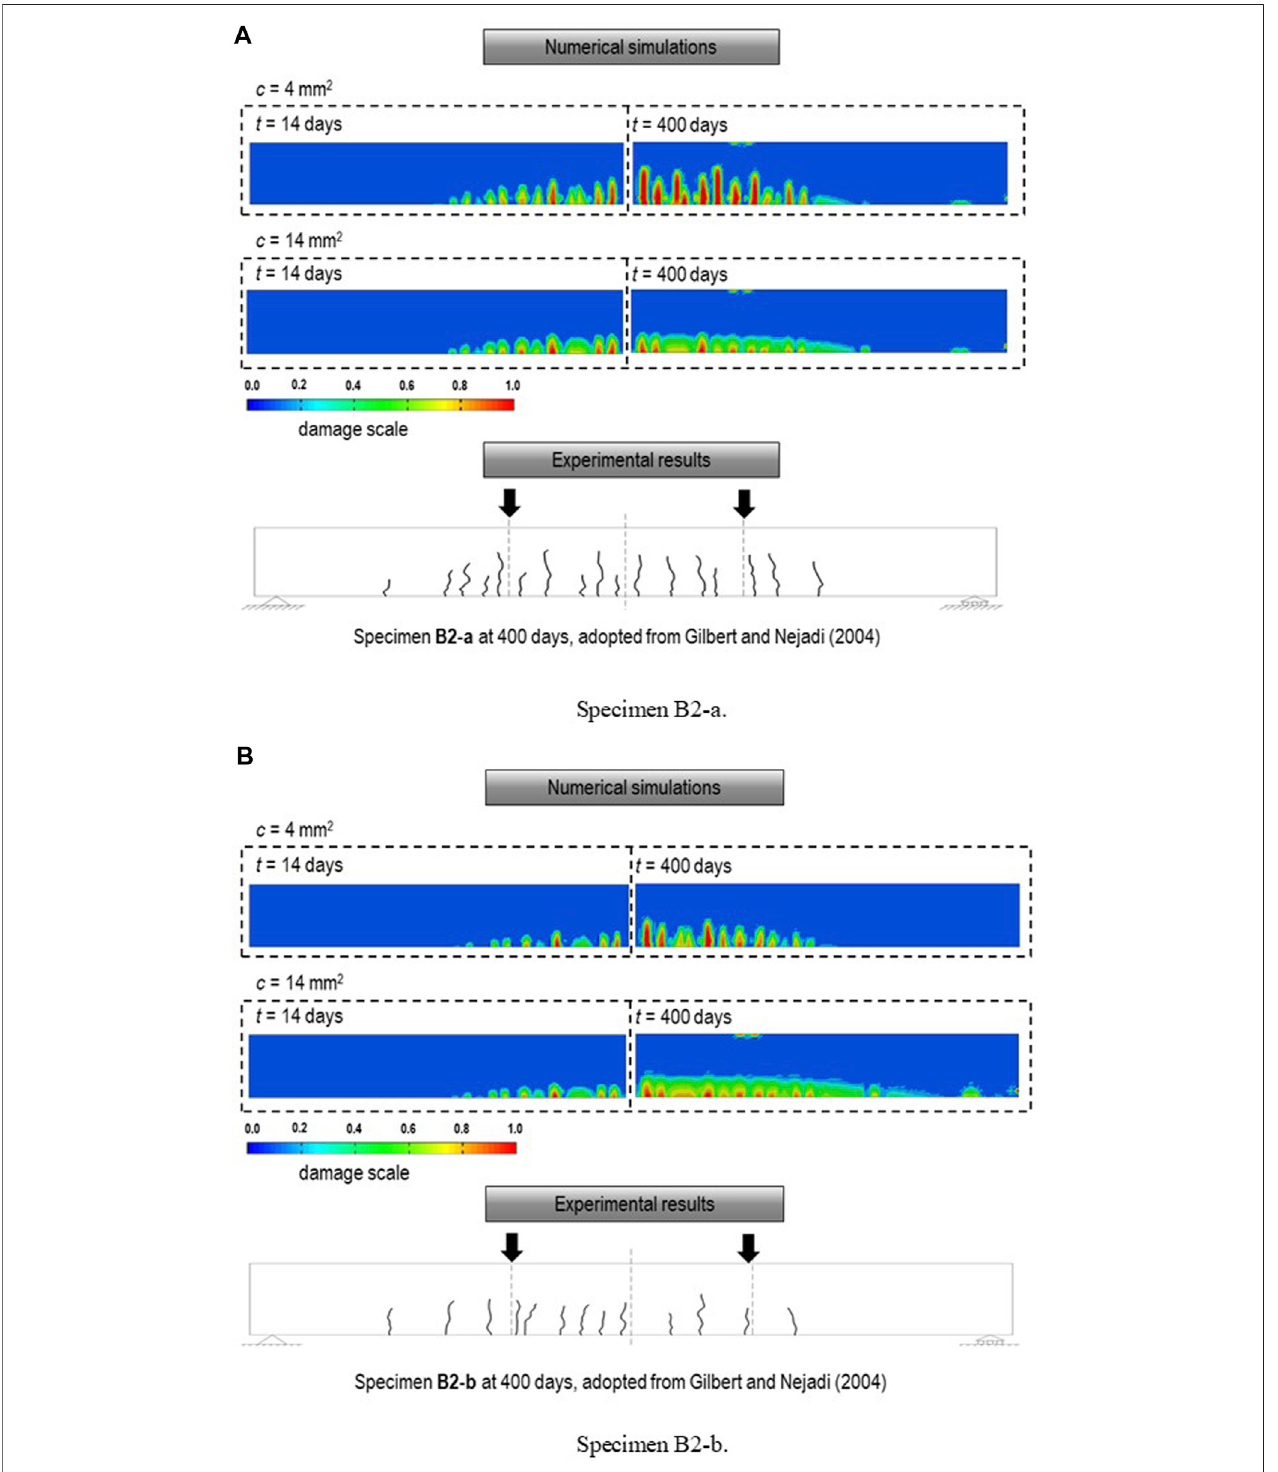
FIGURE 8 | Experimental and numerical crack pro fi les.